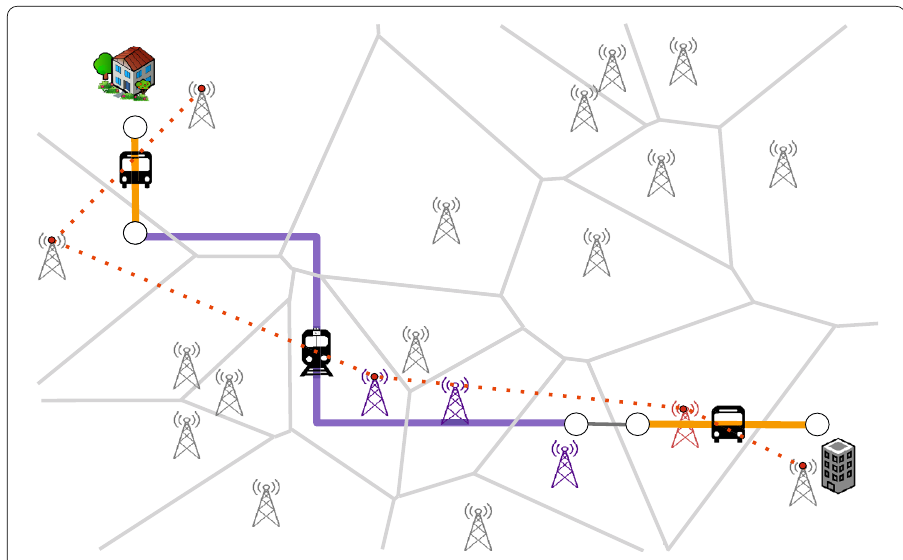
Figure 1 Example of a XDR trajectory for a trip from home to work. The trip is intermodal, with several stages: bus, metro, and bus. The red dotted line depicts the trajectory built by following the user connections. The assignment of towers to each XDR event is approximated by a Voronoi tessellation of the space according to the tower positions. Some mobile phone towers are close to the route followed by the user, however, the user does not necessarily connect to all of them ( e.g. his/her device could connect to towers far from the